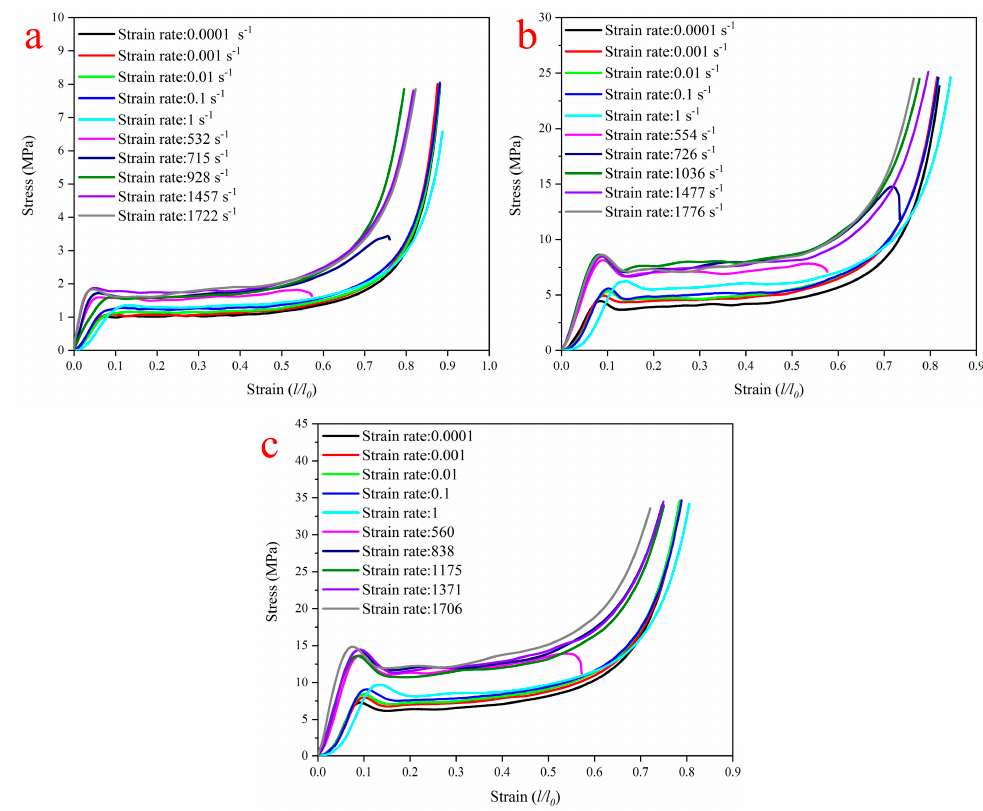
Figure 7. A representative of compressive stress–strain graphs for ( a ) H75, ( b ) H160, and ( c ) H250 at quasi-static conditions.